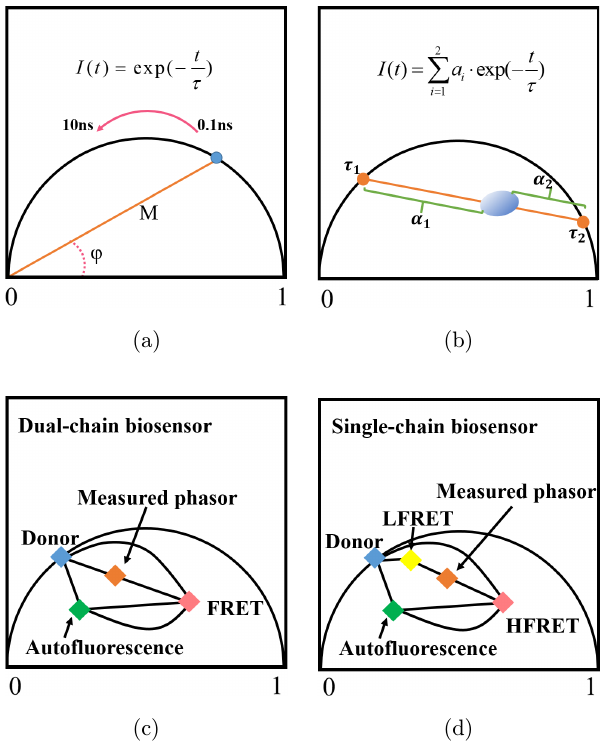
Fig. 2. Schematic diagram of phasor method. (a) Mono- exponential decay simulation; (b) bi-exponential decay simu- lation; (c) double-stranded FRET – FLIM phasor diagram under background in°uence; and (d) single-chain FRET – FLIM phasor diagram under background